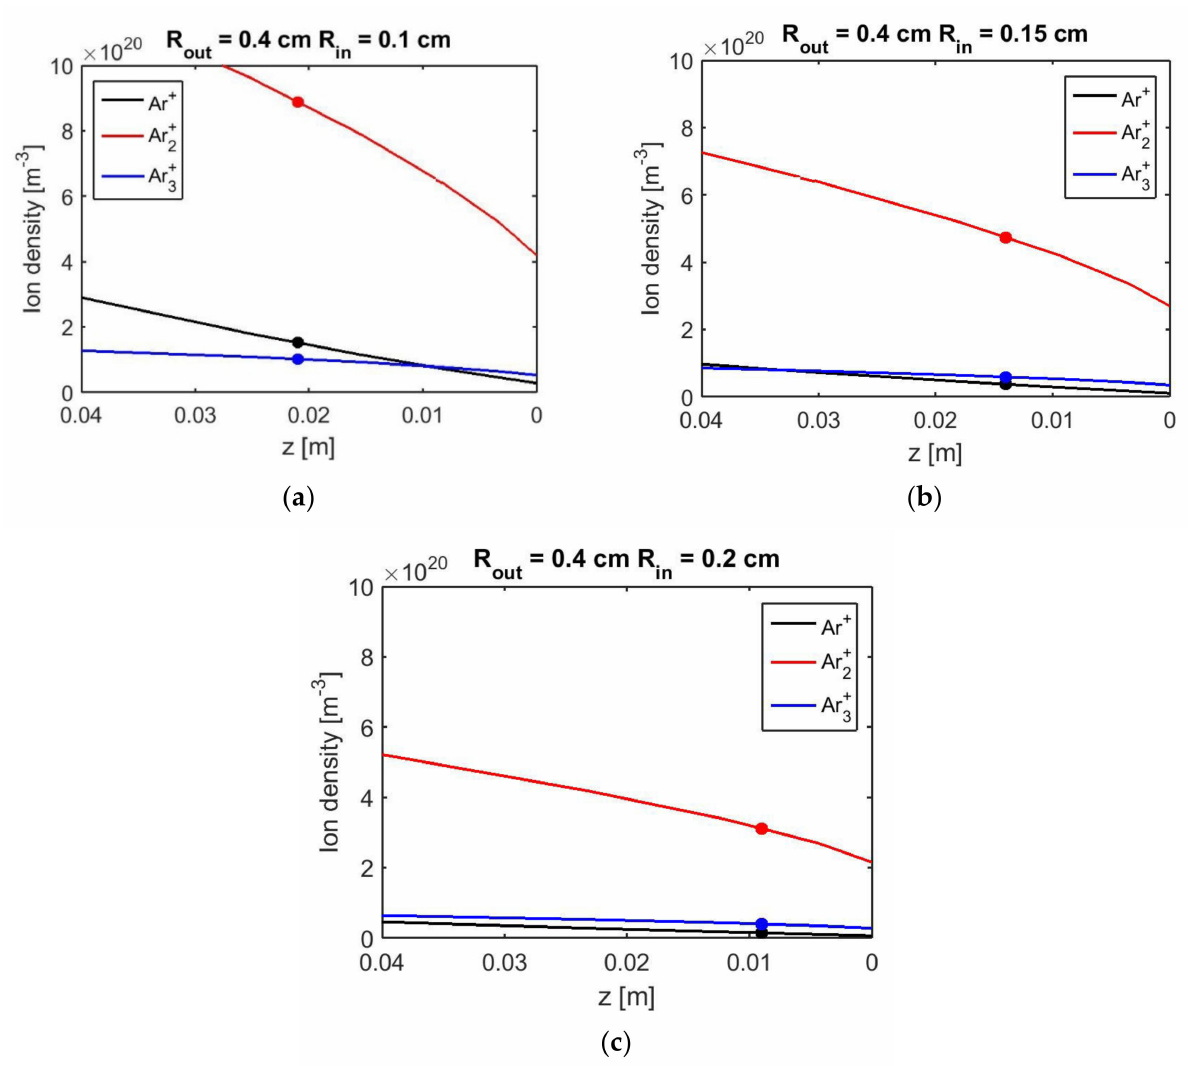
Figure 7. Axial distribution of argon atomic ion Ar + (balck lines) and two molecular ions Ar 2+ (red lines) and Ar 3+ (blue lines) along the plasma column in the three discharge tubes: ( a ) 8 mm/2 mm; ( b ) 8 mm/3 mm; ( c ) 8 mm/4 mm. The dots correspond to the same wave power as in Figure